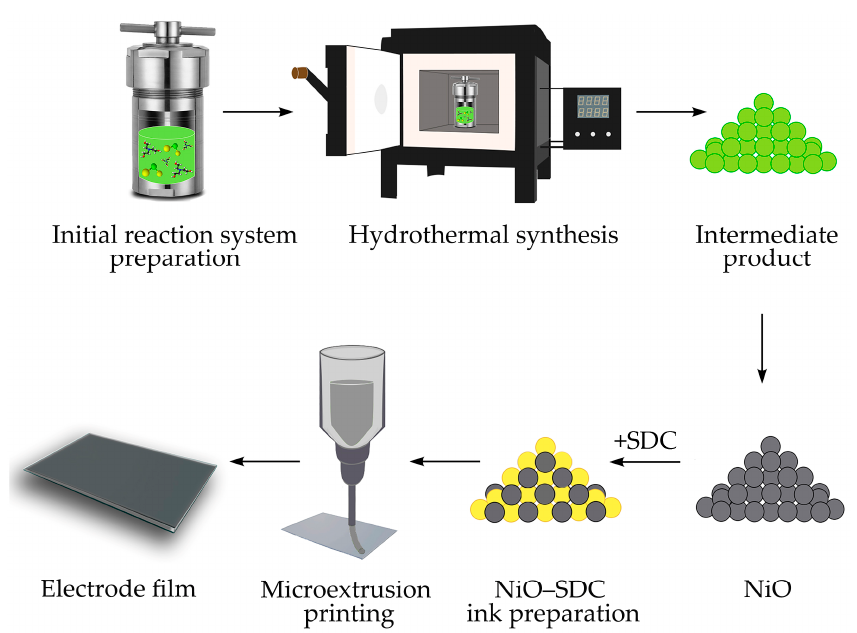
Figure 10. Schematic illustration of NiO synthesis and microplotter printing of the corresponding NiO—SDC film on an Al 2 O 3 substrate.